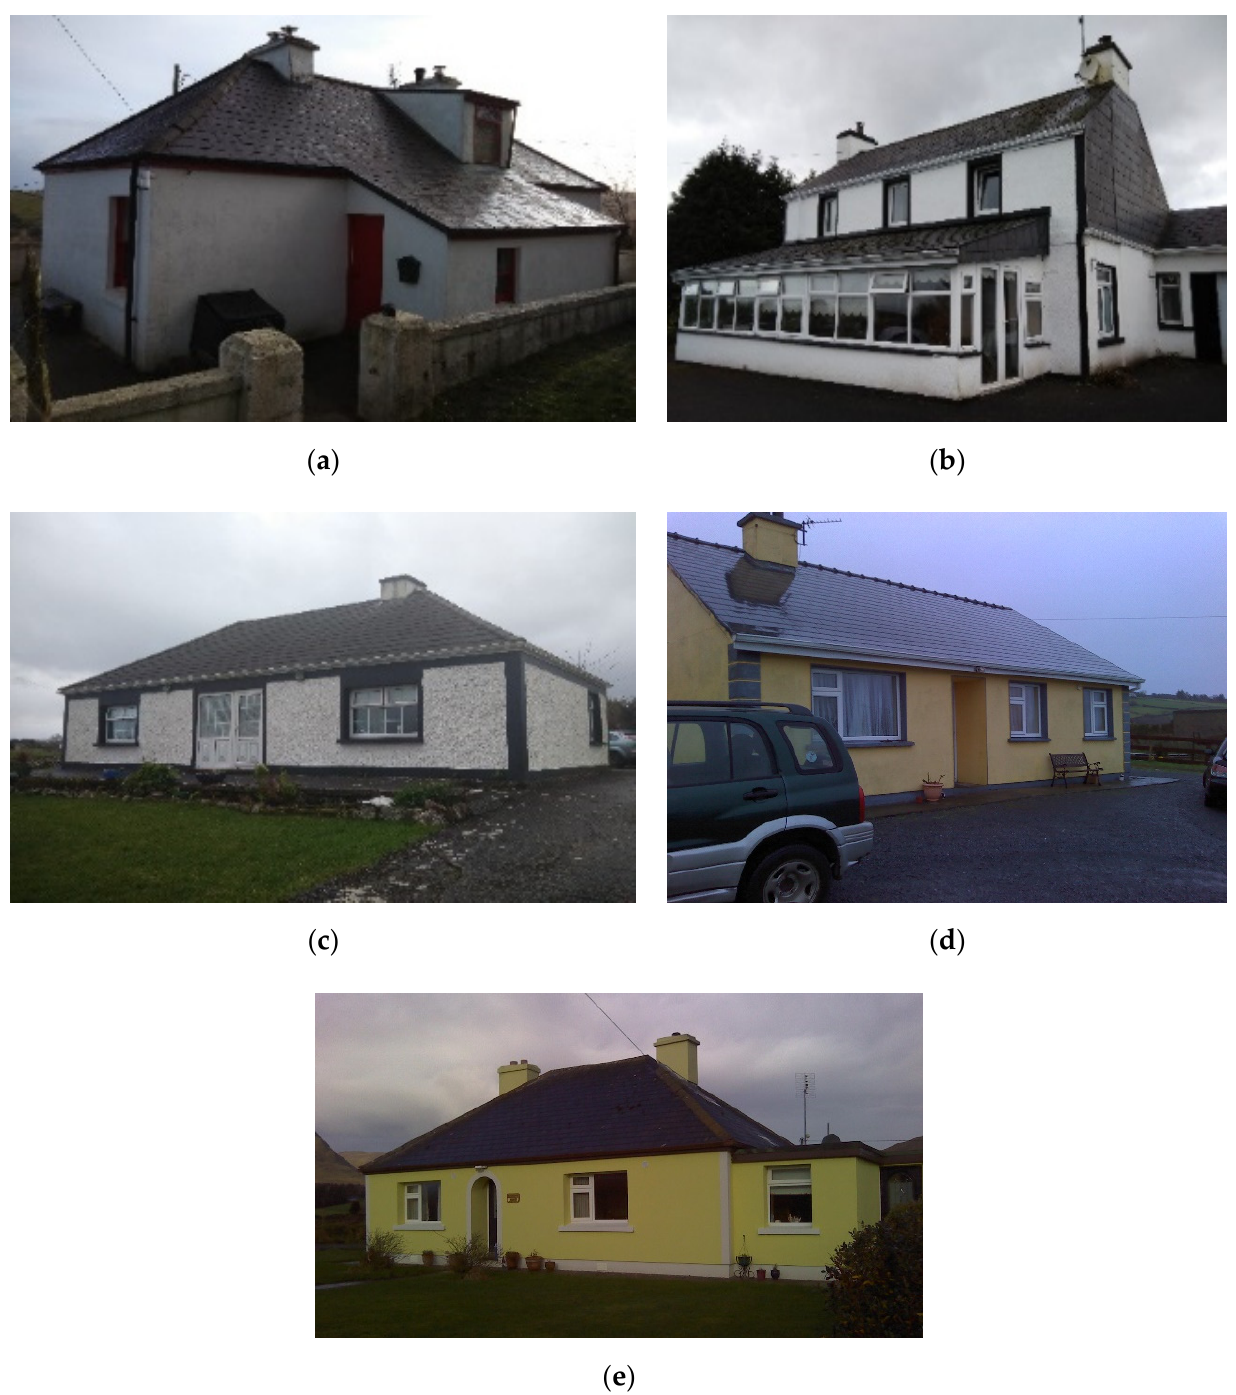
Figure 1. ( a ) Case A, ( b ) Case B, ( c ) Case C, ( d ) Case D, and ( e ) Case